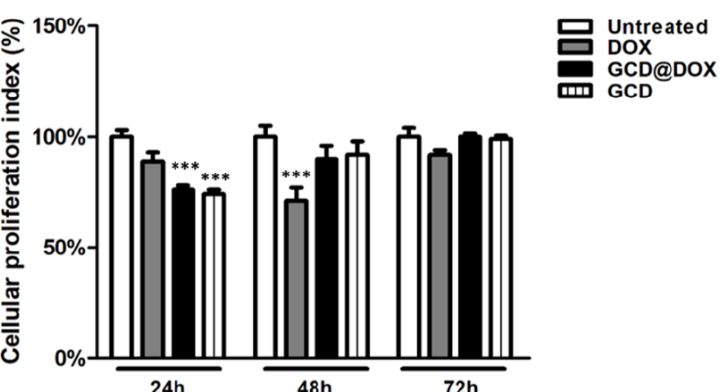
Figure 1. Time course study of biocompatibility of DOX (1.25 µ g/mL), GCD (25 µ g/mL)